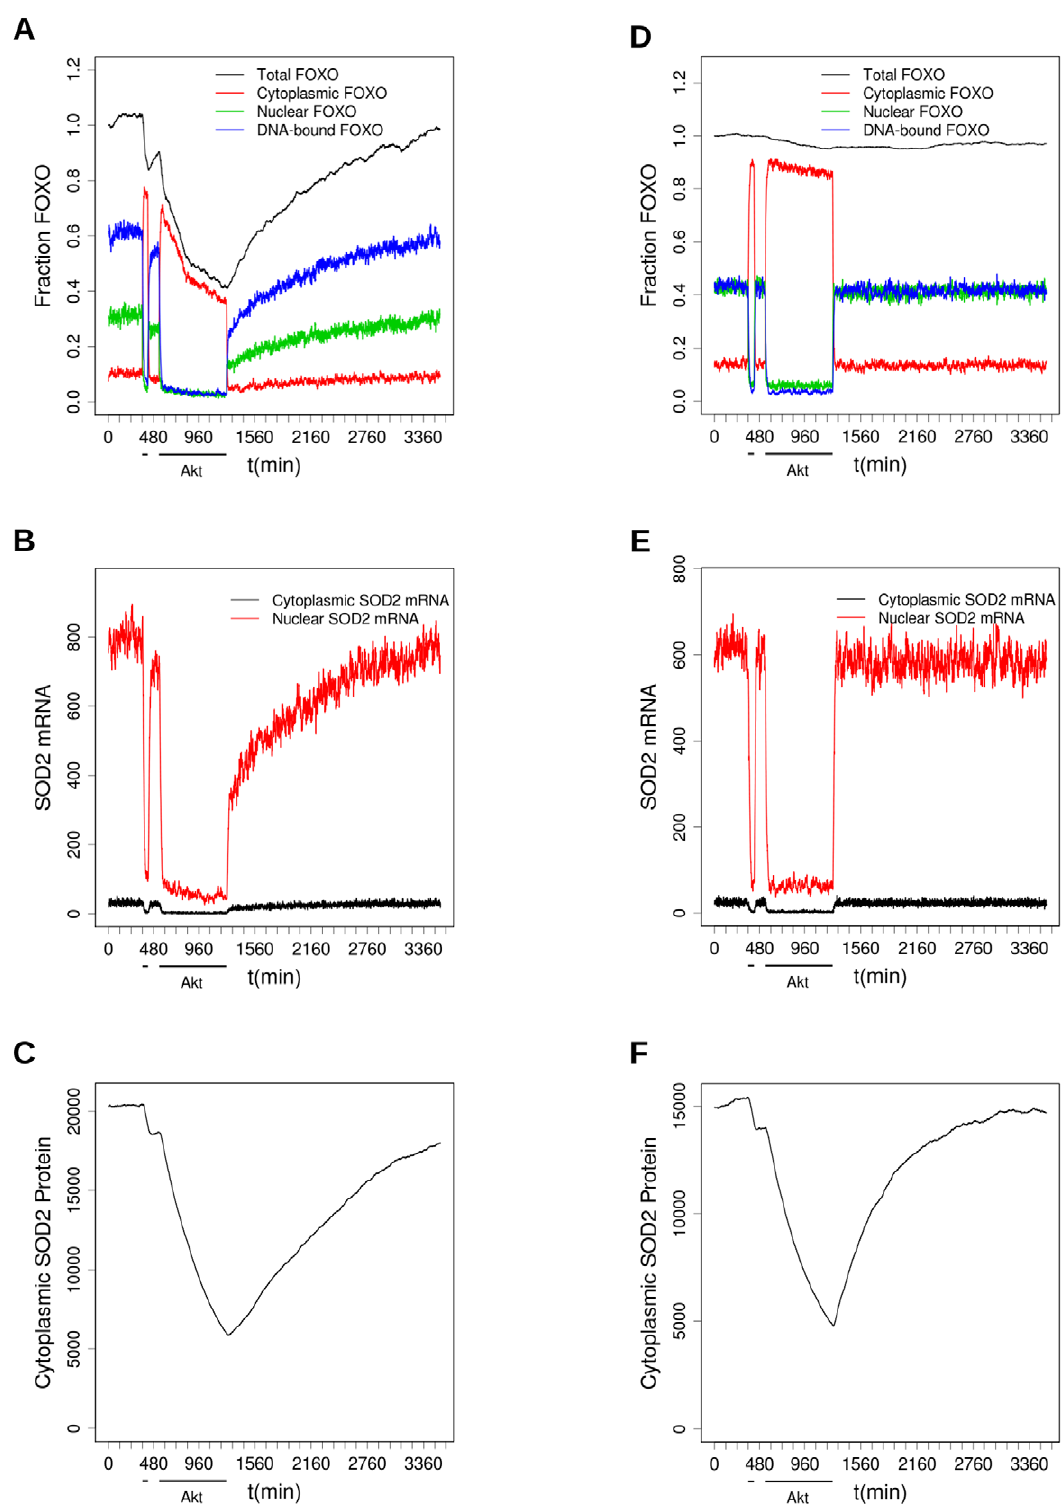
Figure 6. The effect of brief and prolonged Akt activity interacting with degradation and acetylation. Before the start of the time course in the figure, FOXO is pre-equilibrated for 2520 minutes to allow its target gene SOD2 to come into equilibrium, with Akt very weakly active (copy number 100). A–C shows a simulation where acetylation is low (SIRT1=10 3 , CBP/P300=10), whereas in D–E CBP/P300 is high (SIRT1=10, CBP/ P300=10 3 ) so that FOXO is 99% acetylated. As shown by the dosing bars, Akt is activated at t=360 min for 60 min, and again at t=540 min for 720 min. The panels show: (A,D): total FOXO and the amount in each compartment, as a fraction of the total at t=0; (B, E) mRNA in nucleus and cytoplasm for the output gene SOD2; (C,F) SOD2 protein level.